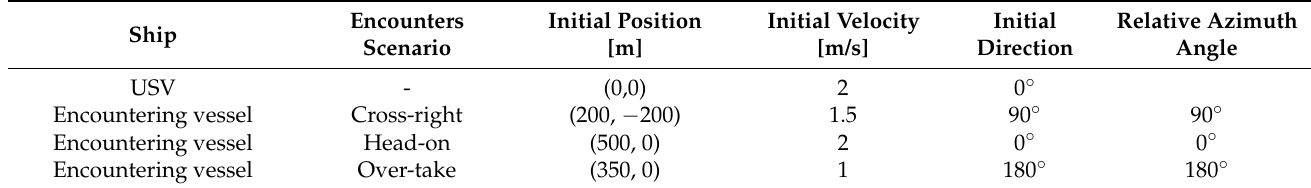
Table 4. Settings of encounter scenario parameters.